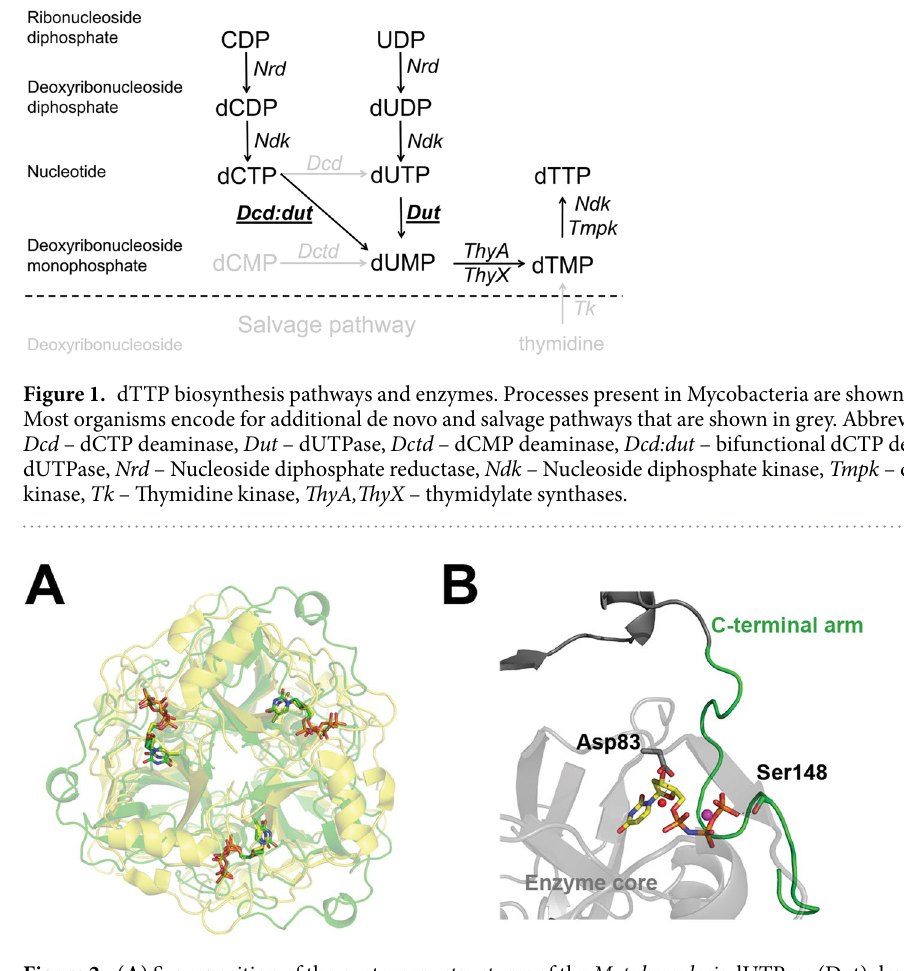
Figure 2. ( A ) Superposition of the quaternary structures of the M. tuberculosis dUTPase (Dut) depicted in green (PDB ID:2PY4) and the M. tuberculosis bifunctional dCTP deaminase/dUTPase enzymes (Dcd:dut) depicted in yellow (PDB ID:2QLP). Note the identical organization of the enzyme core of the homotrimers. Both structures contain the non-hydrolysable substrate analog α - β -imido-dUTP (dUPNPP) in the active sites. ( B ) Enlarged view of the active site of M. tuberculosis Dut showing the C-terminal arm in green. The side chains of the amino acids in case of point mutations and C-terminal arm truncation are shown with atomic colored stick representation similarly to the dUPNPP molecule and with green cartoon representation, respectively. The catalytic water is shown as a red sphere while the yellow sphere denotes the Mg 2 + ion that coordinates the